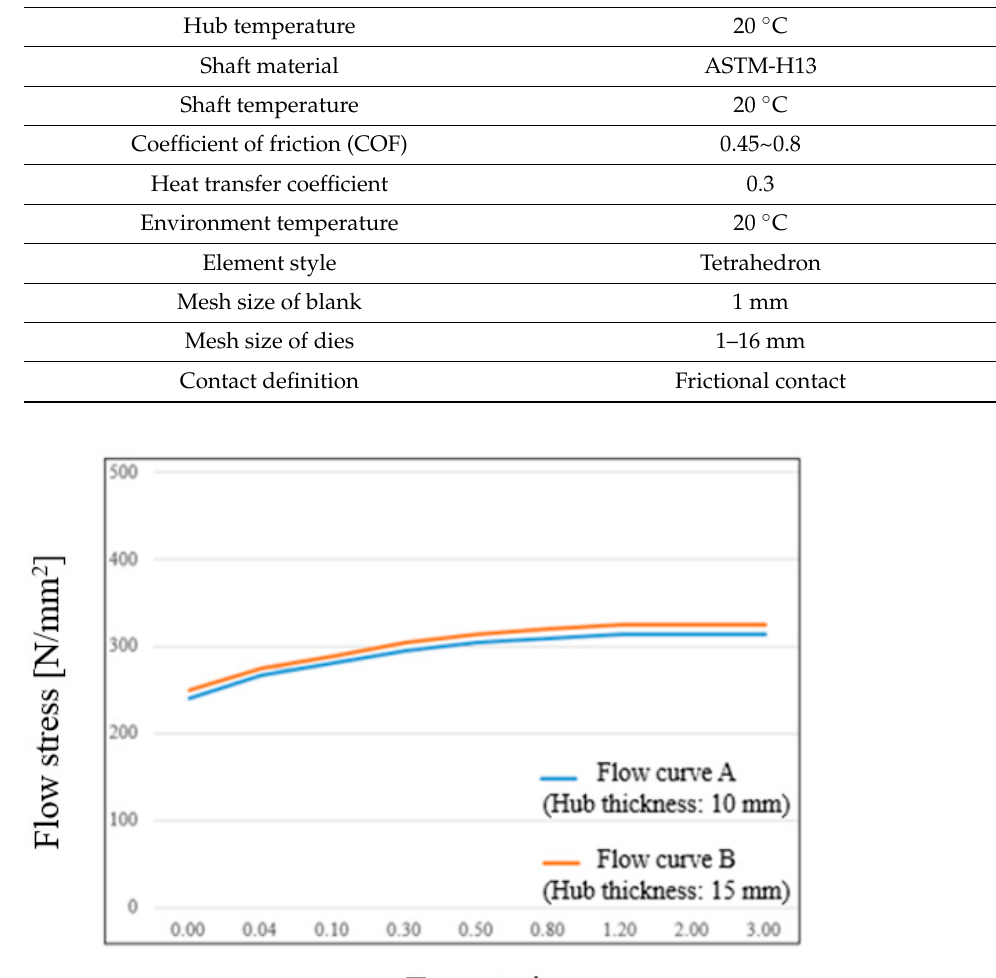
Table 1. Chemical composition of AA6061.